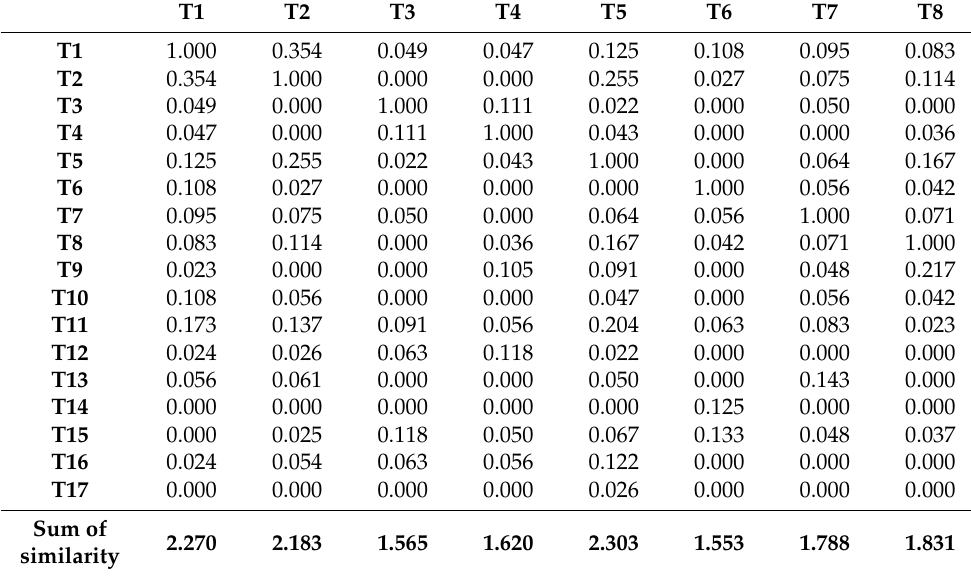
Table 3. Inter-attribute Matrix (IAS)-A.